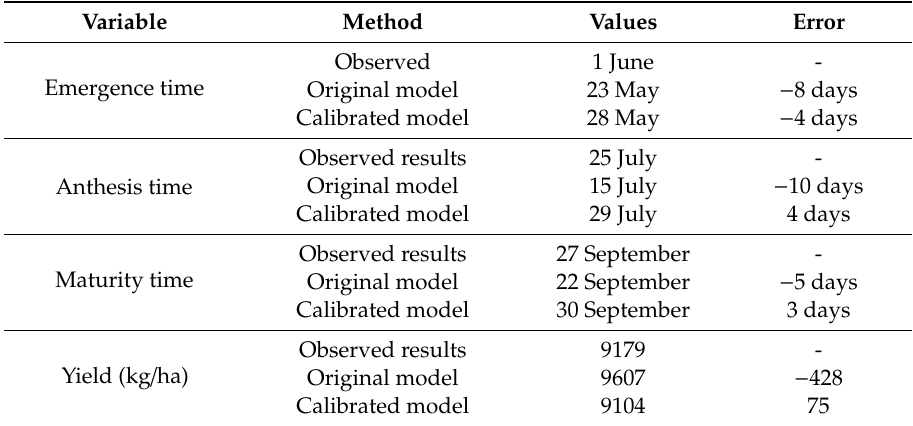
Table 4. Performance of calibrated and un-calibrated WOFOST